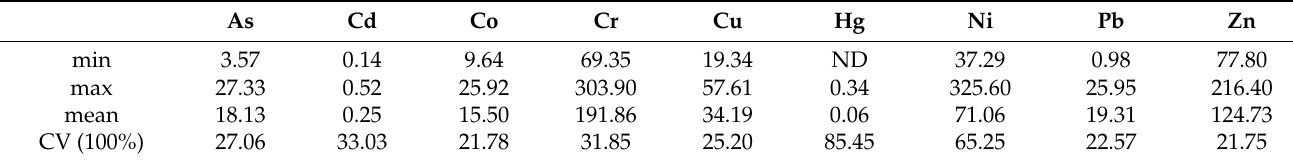
Note: “ND.” means not detected. Table A4. Maximum, minimum, mean, and CV values of heavy metals in soil from Bayannur City. As